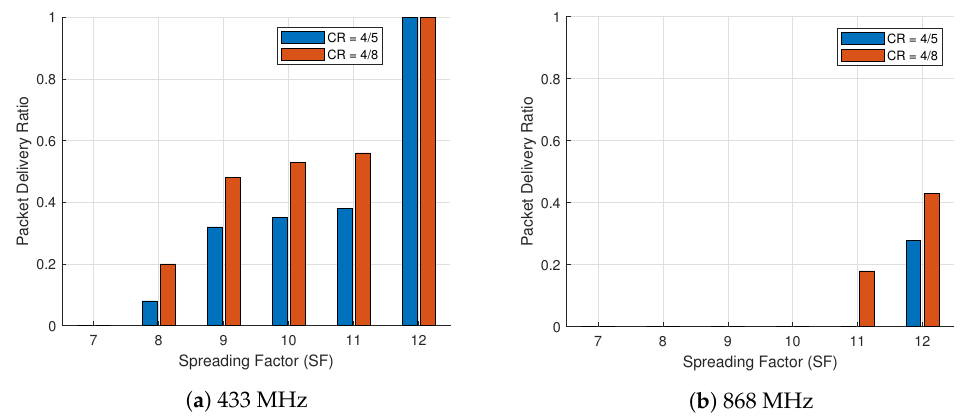
Figure 12. PDR vs. SF varying the CR in POS F ( a ) 433 MHz ( b ) 868 MHz.